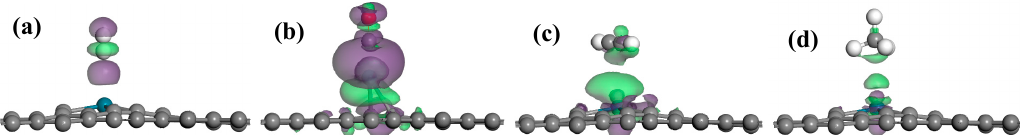
Figure 5. Electron density difference (EDD) of four kinds of molecules adsorbed on Pd-graphyne: ( a ) H 2 adsorption; ( b ) CO adsorption; ( c ) C 2 H 2 adsorption; ( d ) CH 4 adsorption. The purple region denotes the electron accumulation region, while the green region represents electron depletion (the isosurface of (a), (c), and (d) is 0.005 eÅ − 3 ; the isosurface of (b) is 0.02 eÅ − 3 ).